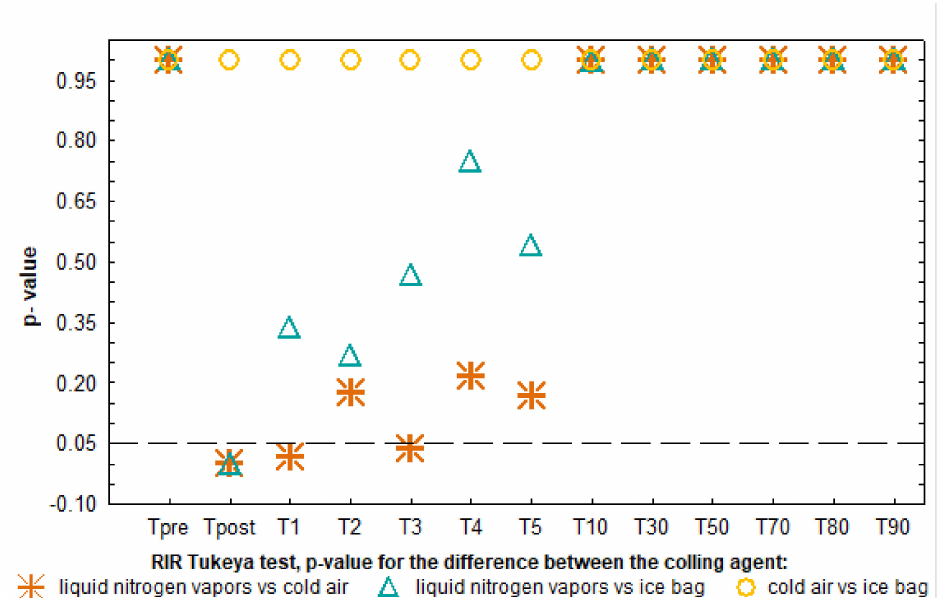
Figure 4. Analysis of changes in the significance of differences over time between surface temperatures after the application of cooling